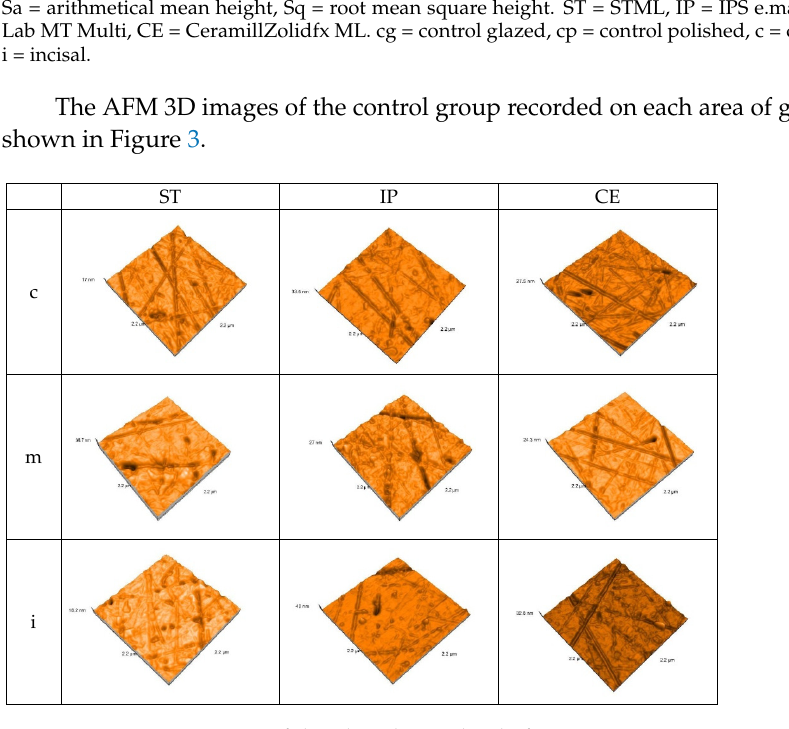
c m i Figure 4. 3D AFM image of the polished samples of the control group. ST= STML, IP= IPS e.maxZirCAD CEREC/in Lab MT Multi, CE= CeramillZolidfx ML, c = cervical, m = medium, i = incisal. After aging, the values for Sa (nm) ‐ arithmetical mean height and Sq (nm) ‐ root mean square height resulted for the glazed samples and polished samples are shown in Table 7.